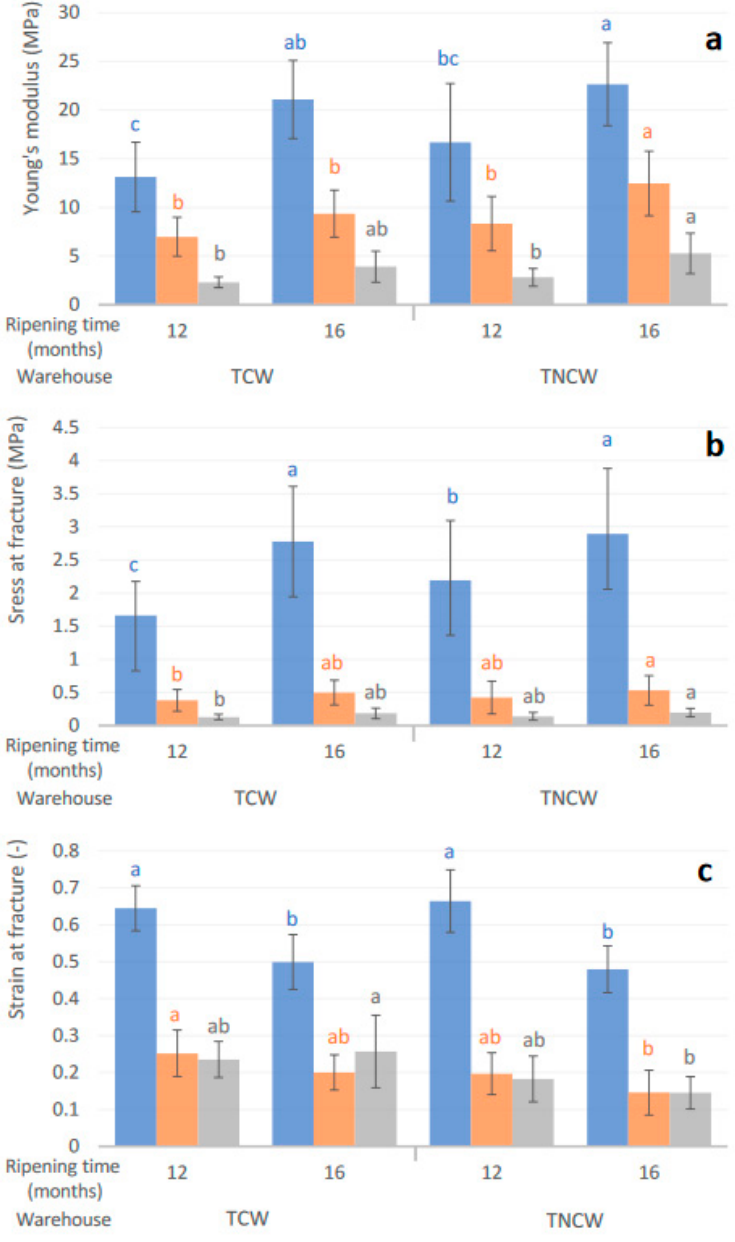
Figure 4. Young’s modulus ( a ), stress ( b ) and strain at fracture ( c ) of Nostrano Valtrompia cheeses ripened for 12 and 16 months in temperature conditioned warehouse (TCW) and traditional non conditioned warehouse (TNCW). Blue: rind; orange: underrind; grey: inner part of the cheese. Lower case letters (a–c) indicate significant differences ( p < 0.05) within the same cheese zone (rind, underrind, inner part).